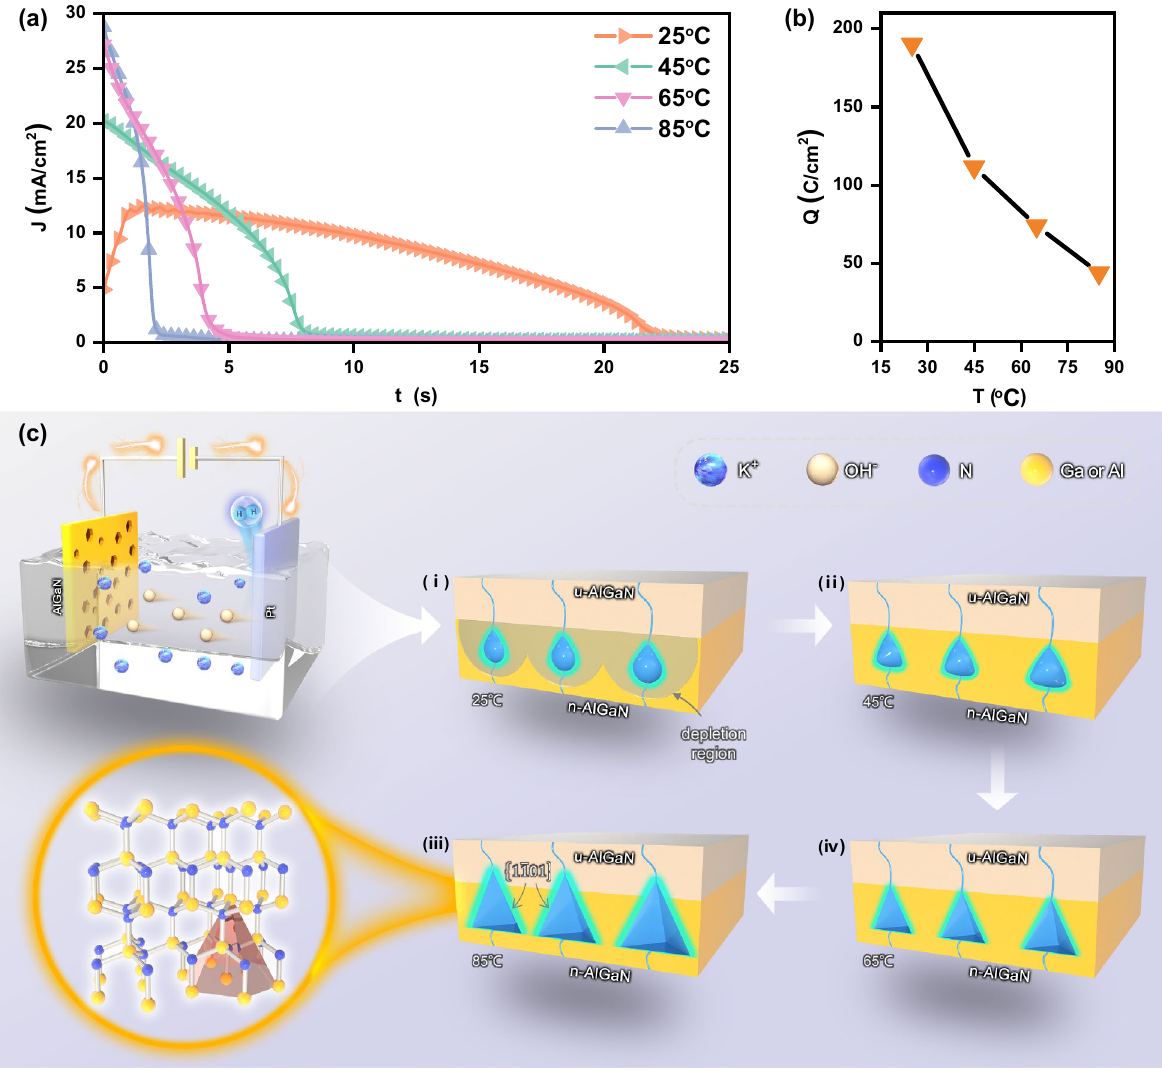
Figure 3. ( a ) J–t plots of DBRs etched in KOH solution at 25 V and different temperatures; ( b ) The integrated charge density as a function of temperature; ( c ) Schematic illustration of the electrochemical etching cell, nanopores etched in KOH solution at 25 V and different temperatures and AlGaN crystal